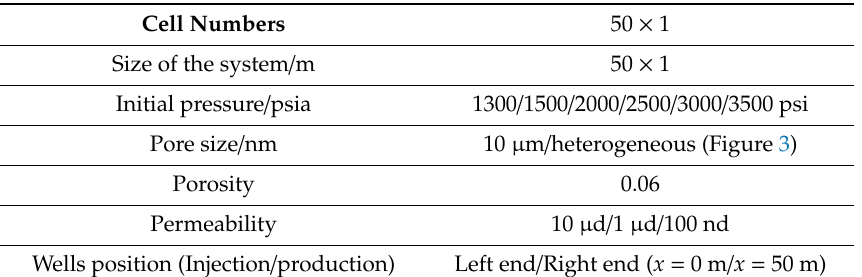
Table 4. Properties of slim tube simulation